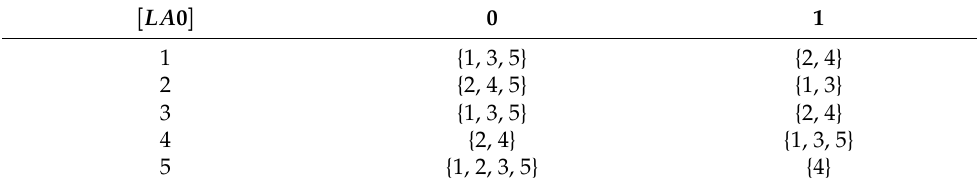
Table 1. Adjacency layers ( LA 0 i , k ← { j | Ad i , j = k } ) for Figure